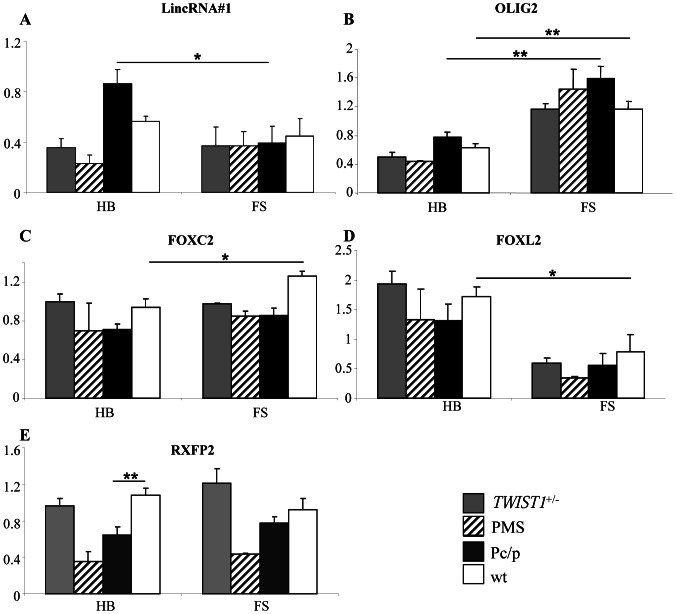
RT-qPCR gene expression analyses in tissues from wild-type, PC/p, TWIST1+/− and PMS 90 dpc fetuses.HB: horn buds+frontal bone, FS: frontal skin+frontal bone. *p<0.05 and **p<0.01 (Fischer’s test). P-values were not calculated for expression levels in tissues from TWIST1+/− and PMS fetuses due to the small number of individuals investigated.